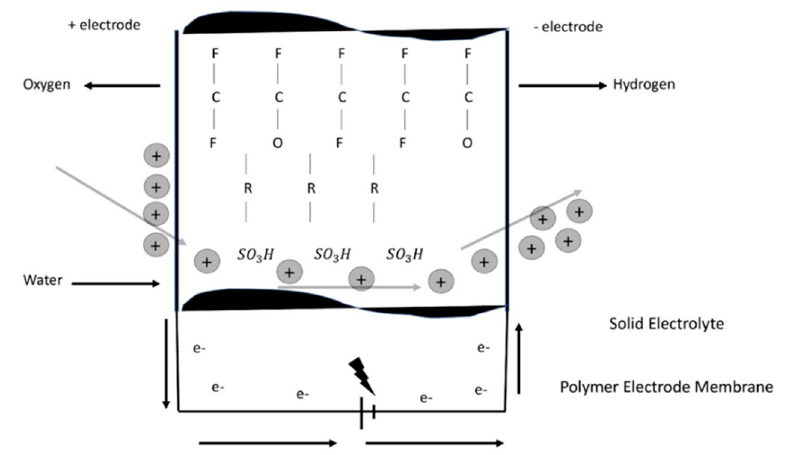
Figure 4. Working mechanism of a PEM electrolysis cell.